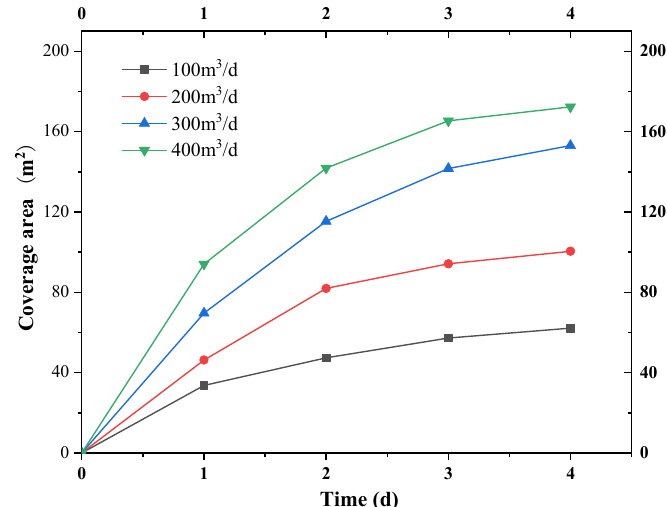
Figure 16. Variation curve of bacterial coverage area with time.